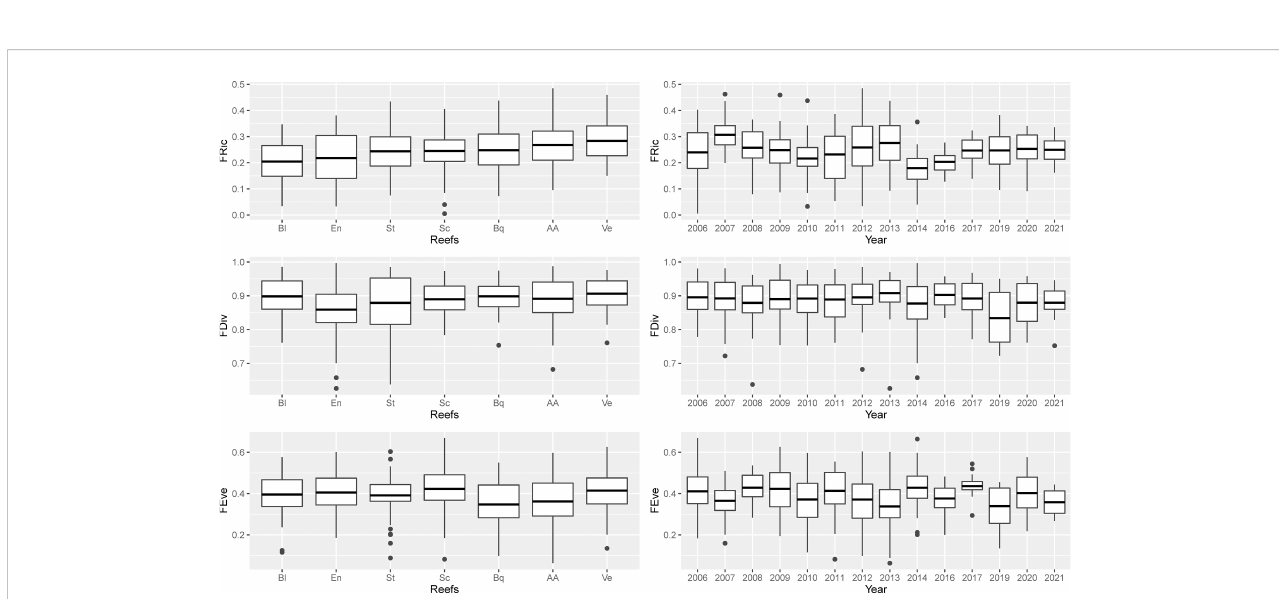
FIGURE 4 Boxplot with spatio-temporal variation in functional diversity (FD) metrics by reef and years. Values of FD metrics are express as mean rather than median. Functional diversity metrics were calculated with four coordinate axes that explained 73.87% of the cumulative total variation of fi sh species in the functional trait space. Functional richness (FRic), divergence (FDiv), and evenness